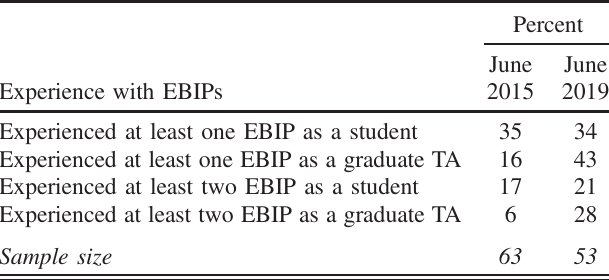
TABLE IV. Experience with evidence-based instructional prac- tices as a TA or student.